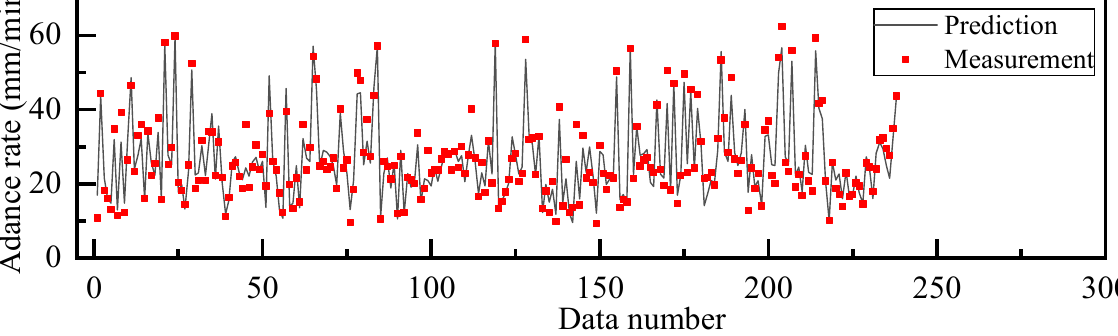
Figure 10. Comparison of AR obtained with the BPNN model and actual measured value on test set.